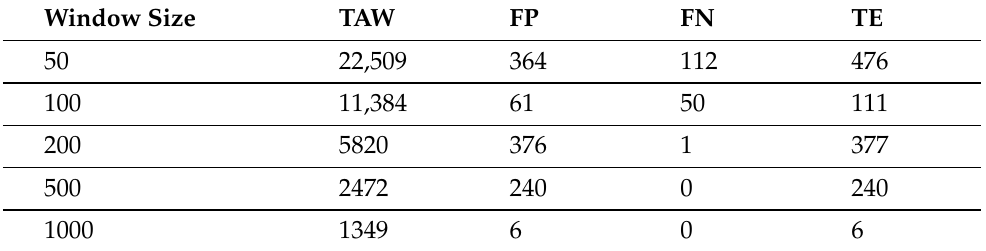
Table 7. Total error (fuzzy